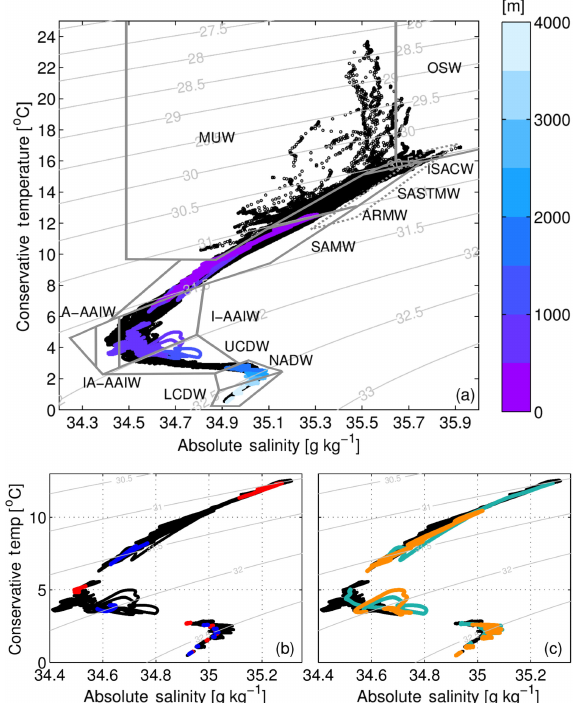
Figure 11. (a) Conservative temperature ( ◦ C)–absolute salinity (gkg − 1 ) relationship from the hydrographic cruises sampling along the SAMBA-east array on board the RV SA Agulhas II (black dots) and from the SBE37 MicroCAT measurements at M4 (depth – colored circles). The gray contours represent the potential density anomaly with a reference pressure of 1000dbar. Water masses are indicated by gray boxes (OSW – Oceanic Surface Water; MUW – Modified Upwelled Water; lSACW – Light South Atlantic Cen- tral Water; SASTMW – South Atlantic Subtropical Mode Water; SAMW – Subantarctic Mode Water; ARMW – Agulhas Ring Mode Water; I-AAIW – Indian Antarctic Intermediate Water; IA-AAIW – Indo-Atlantic Antarctic Intermediate Water; A-AAIW – Atlantic Antarctic Intermediate Water; UCDW – Upper Circumpolar Deep Water; NADW – North Atlantic Deep Water; LCDW – Lower Cir- cumpolar Deep Water). (b, c) Close-up views of the deep water recorded with the MicroCat illustrating the distributions observed in the anticyclonic/cyclonic cases (b) and intrusion cases (c) . The col- ors represent the measurements during each case study(anticyclonic eddy: red; cyclonic eddy: blue; intrusions: cold water – green, warm water –